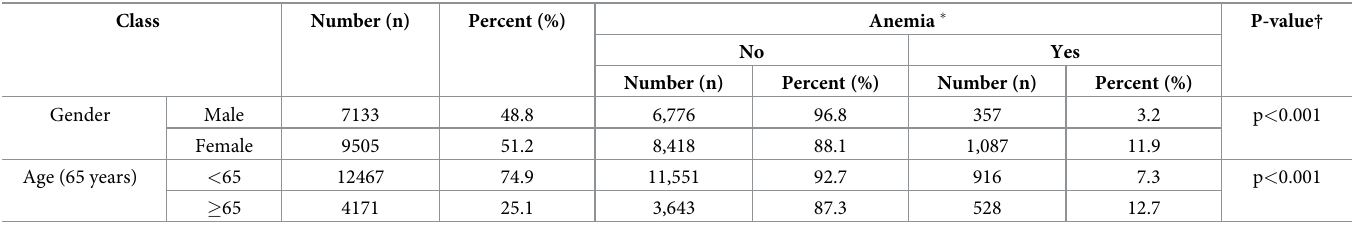
Table 2. Description of anemia status among the study participants.